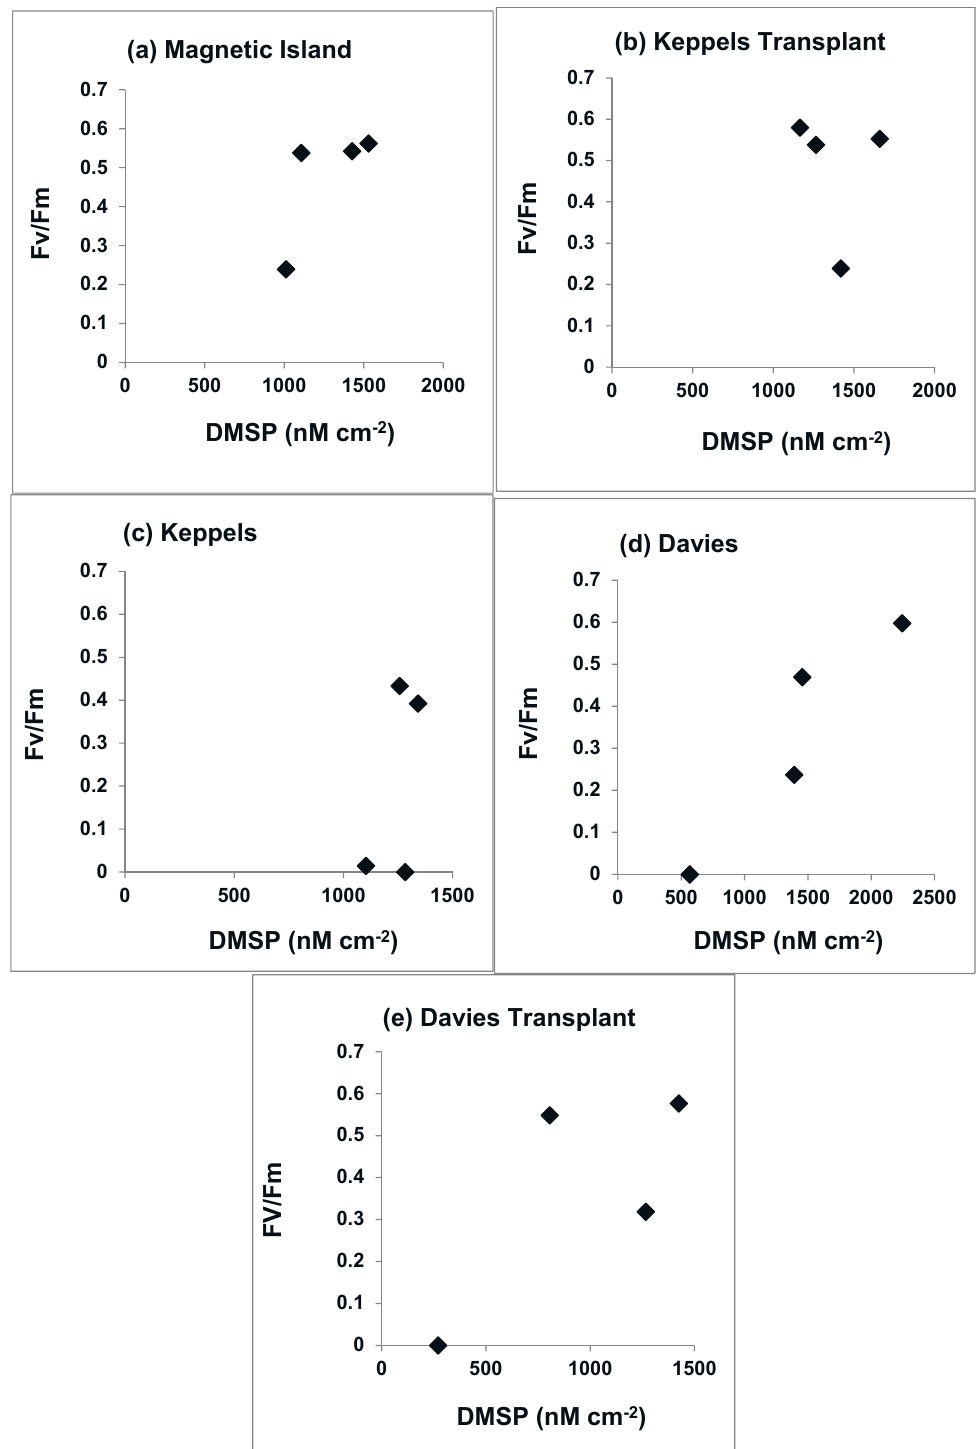
Figure 4. PAM yield of dark-adapted Acropora millepora colonies and DMSP concentrations of the five coral populations at the end of the time course of the experiment for the four temperature treatments. (Measurements of Fv/Fm are taken from Berkelmans and van Oppen (2006),